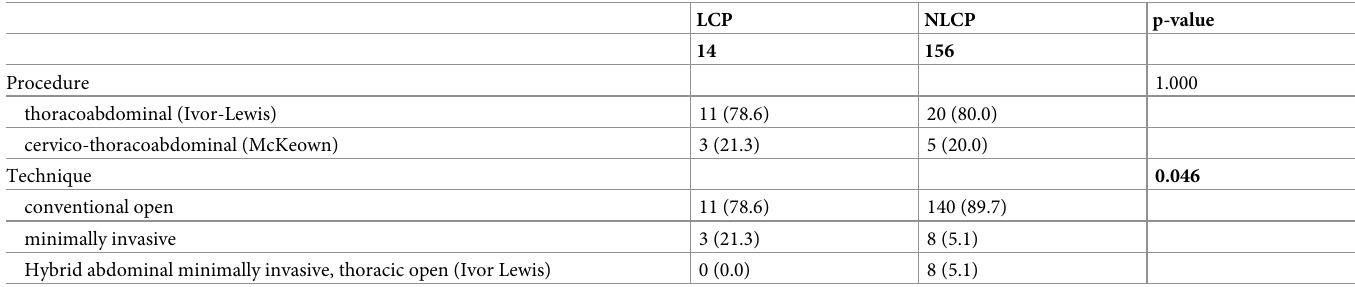
Table 2. Liver-specific clinicopathological parameter of cirrhotic patients.